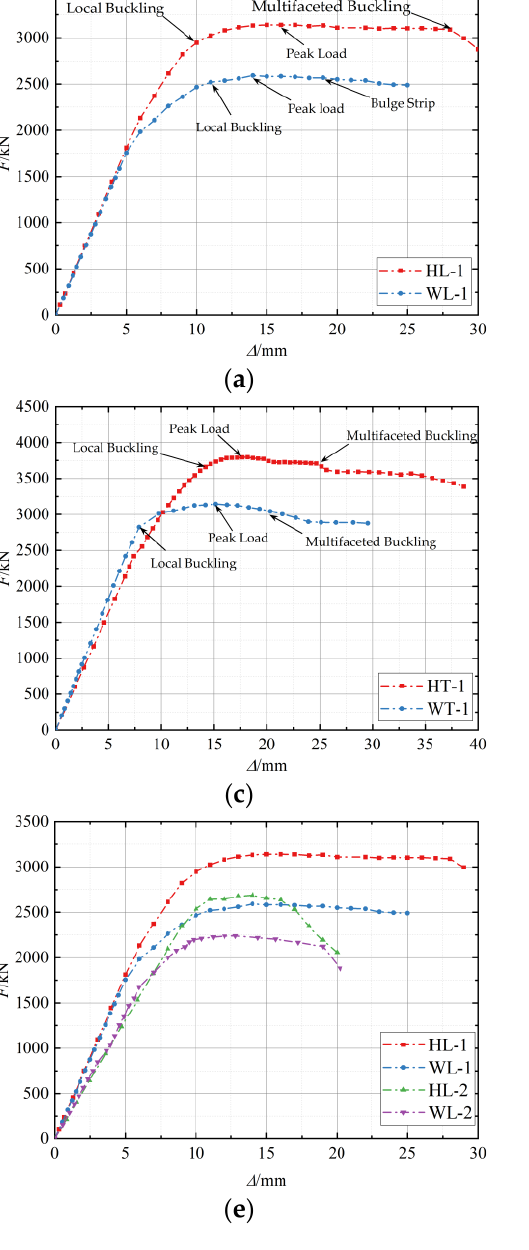
Figure 12. Load-longitudinal displacement curves ( a ) HL-1 and WL-1; ( b ) HL-2 and WL-2; ( c ) HT-1 and WT-1; ( d ) HT-2 and WT-2; ( e ) L-shaped; ( f ) T-shaped.